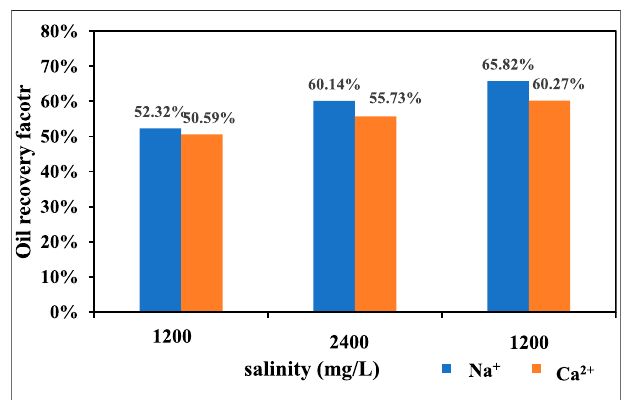
FIGURE 9 | Oil recovery of quzrtz sand packs displaced by different salinity of CaCl 2 .